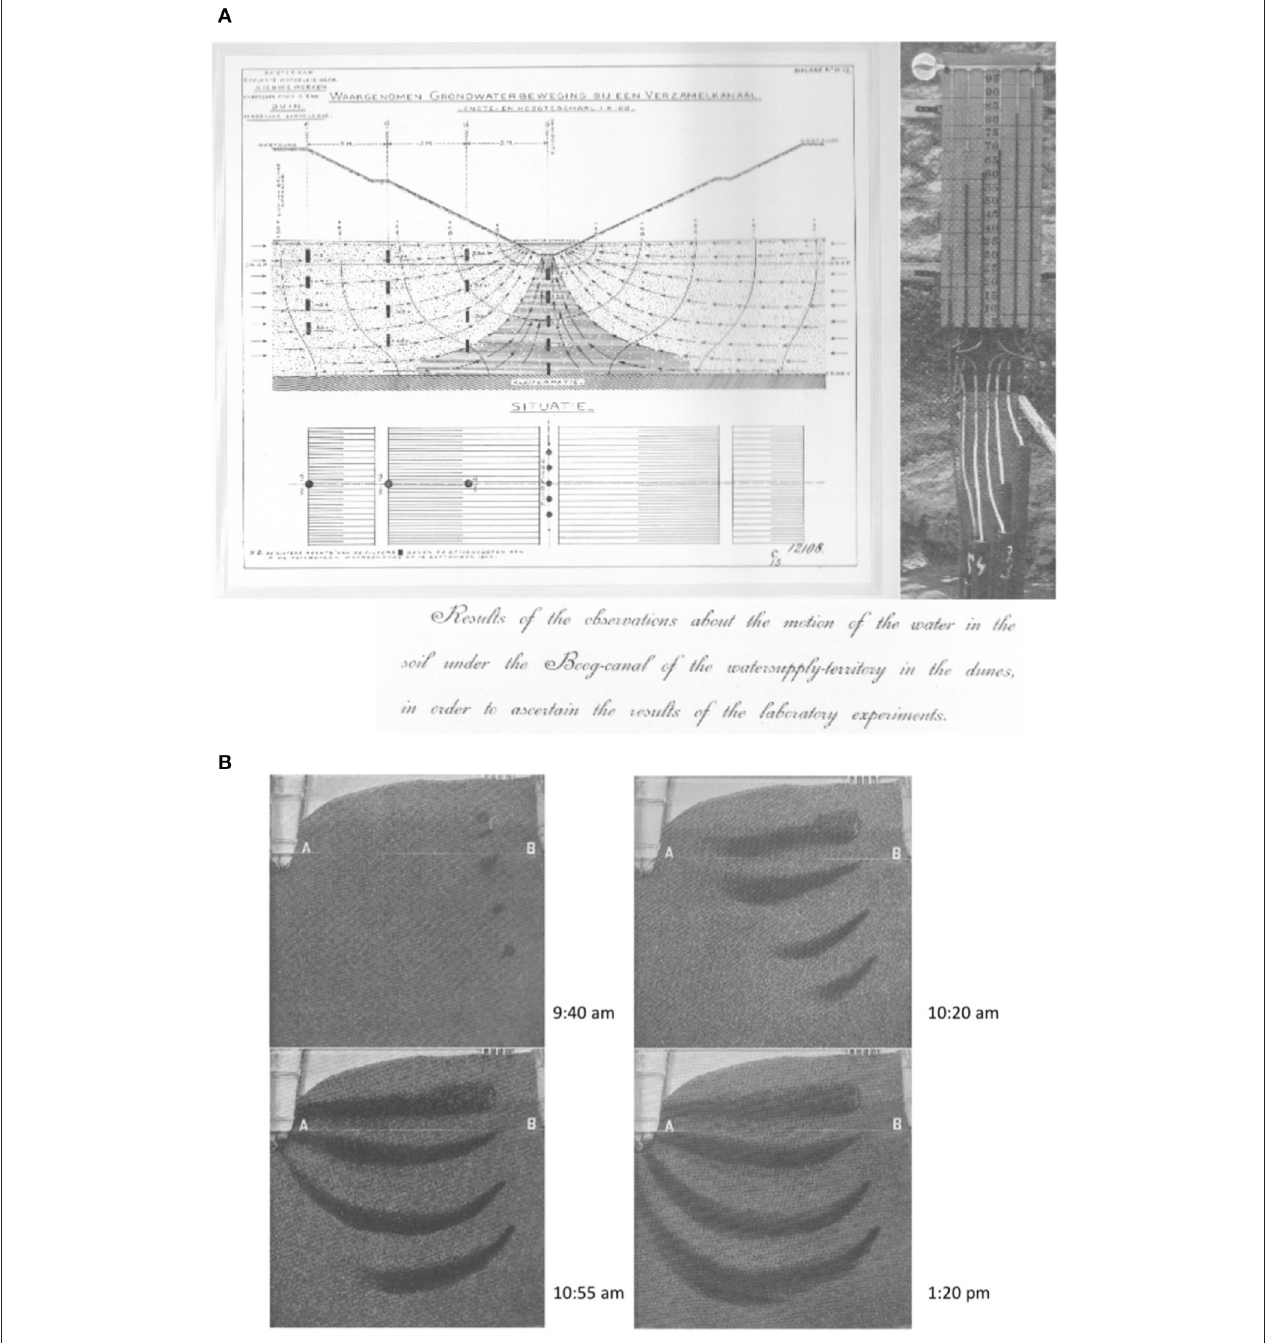
FIGURE 2 | (A) Flow pattern based on observed total head in a field, and (B) streamlines made visible with Indian ink in a sand tank model, both copied from Pennink (1905), with permission from the Royal Netherlands Society of Engineers (KIVI).